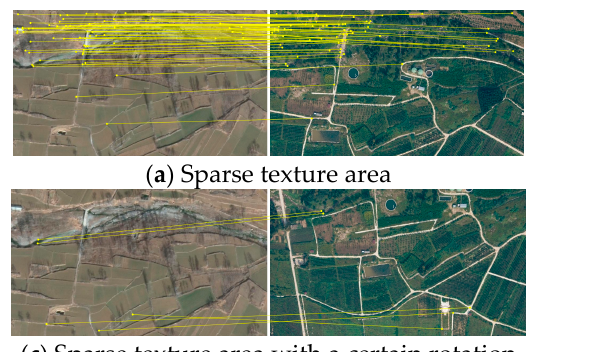
Figure 12. Partial matching results of CFOG on the test dataset.